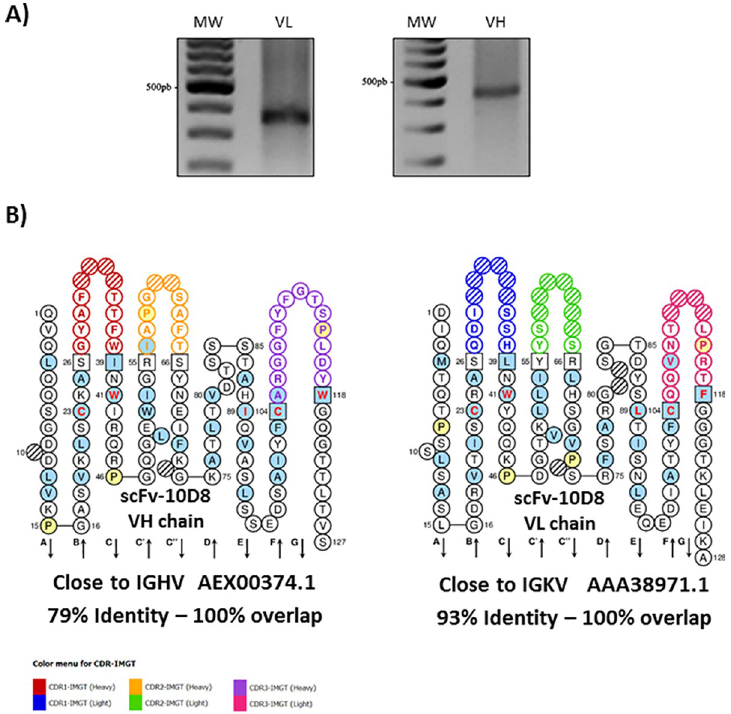
Fig 1. Amplification and assembly of a scFv. a Amplification of the light and heavy variable regions of mAb-10D8. Light variable portion amplification products are about 350 bp and heavy variable portion amplification products are about 400 bp. PCR products were obtained using cDNA as template. b Bidimensional representation of the scFv-10D8 (accession # MN106365) by IMGT/Collier de Perles highlighting the hypervariable regions (CDRs) of each variable chain. The amino acid residues were numbered according to the standard IMGT. Residues at positions 23, 41, 89, 104 and 118 are critical for the antibody structure and function. The coloured circles correspond to the CDRs of each chain, and the hatched circle indicates gaps that have been introduced for better alignment with the sequences of deposited variable regions.